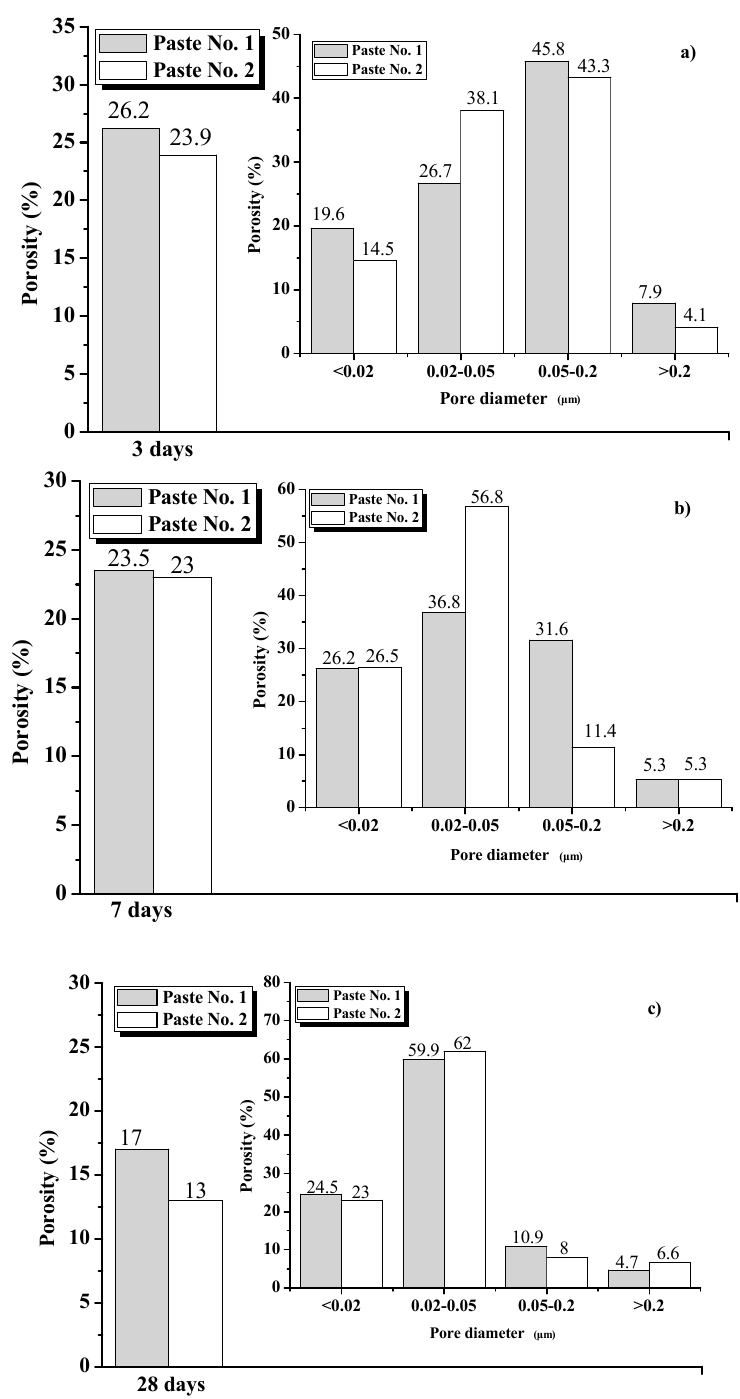
Figure 7. Total porosity of Pastes No. 1 and No. 2 at different ages of: ( a ) 3 days; ( b ) 7 days and ( c ) 28 days, for different pore sizes in the ranges of <0.02 μ m, 0.02–0.05 μ m, 0.05–0.2 μ m and >0.2 μ m.